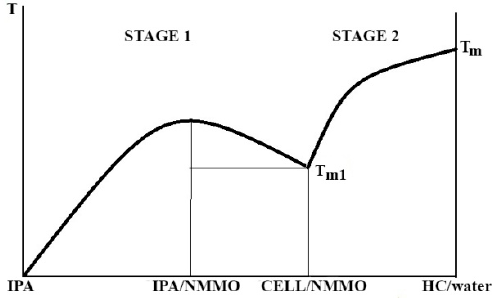
Figure 18. Schematic diagram of the formation of a cellulose fiber / film at interaction of a cellulose solution with isopropanol (amorphous equilibrium) and deposition of hydrate cellulose by water (crystalline equilibrium).